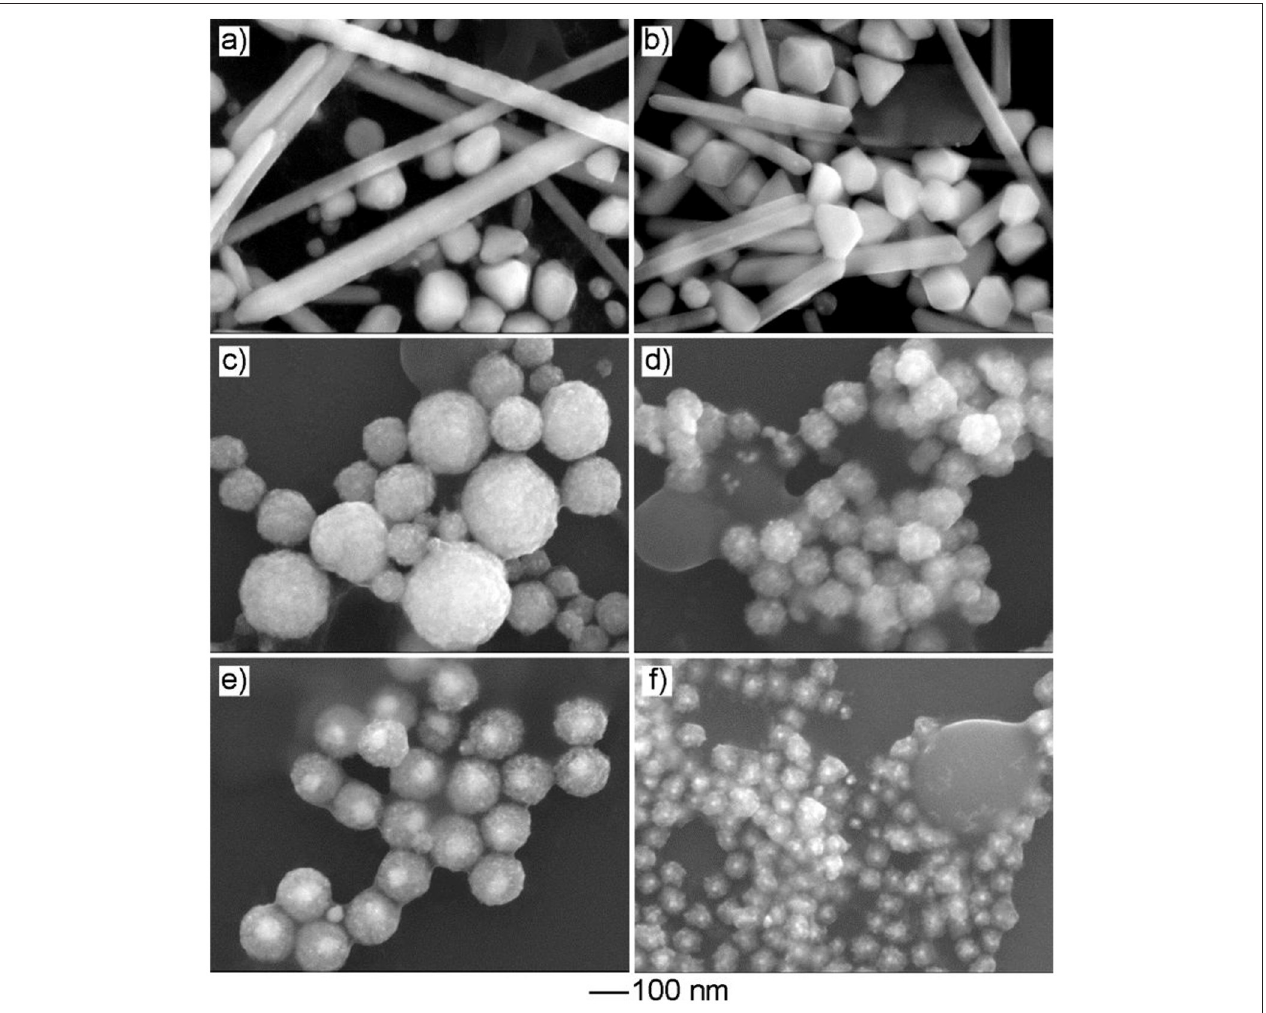
FIGURE 5 | The effect of the Cu precursor on product morphology. The SEM images of the products obtained via the standard procedure, except that the Cu precursor was replaced by: (a) CuCl 2 , (b) CuBr 2 , (c) Cu(NO 3 ) 2 , (d) CuSO 4 , (e) Cu(OAc) 2 , and (f) Cu(CA) 2 , respectively.